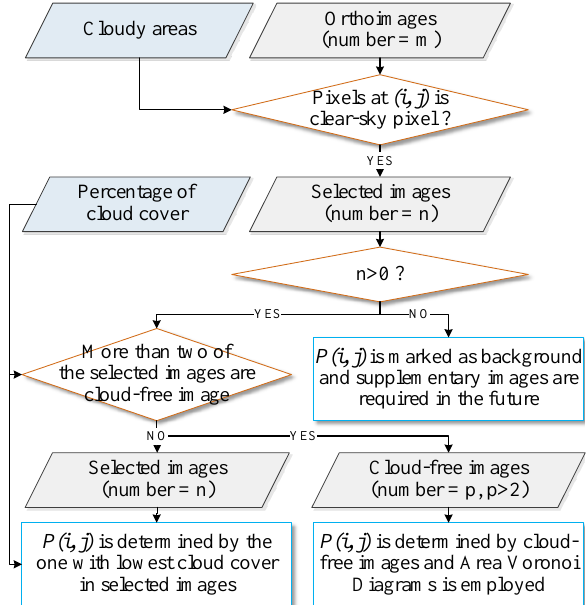
Figure 5. Flow Chart of Seamline